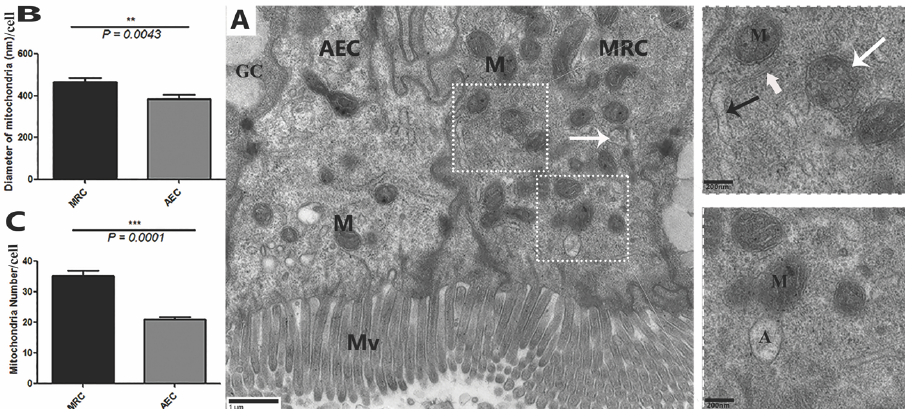
Figure 2. Transmission electron micrograph of the morphological comparison of mitochondria-rich cells (MRCs) with AECs and GCs of P. sinensis . ( A ) mitochondria-rich cell (MRC), absorptive epithelial cell (AEC), goblet cell (GC), mitochondria (M), autophagosome (A), microvillus (Mv), multivesicular bodies (white arrow), Golgi complex (thick white arrow) and endoplasmic reticulum (thin black arrow). ( B ) Quantification of the diameter of mitochondria and ( C ) number of mitochondria. Scale bar = (A) 1 µm.